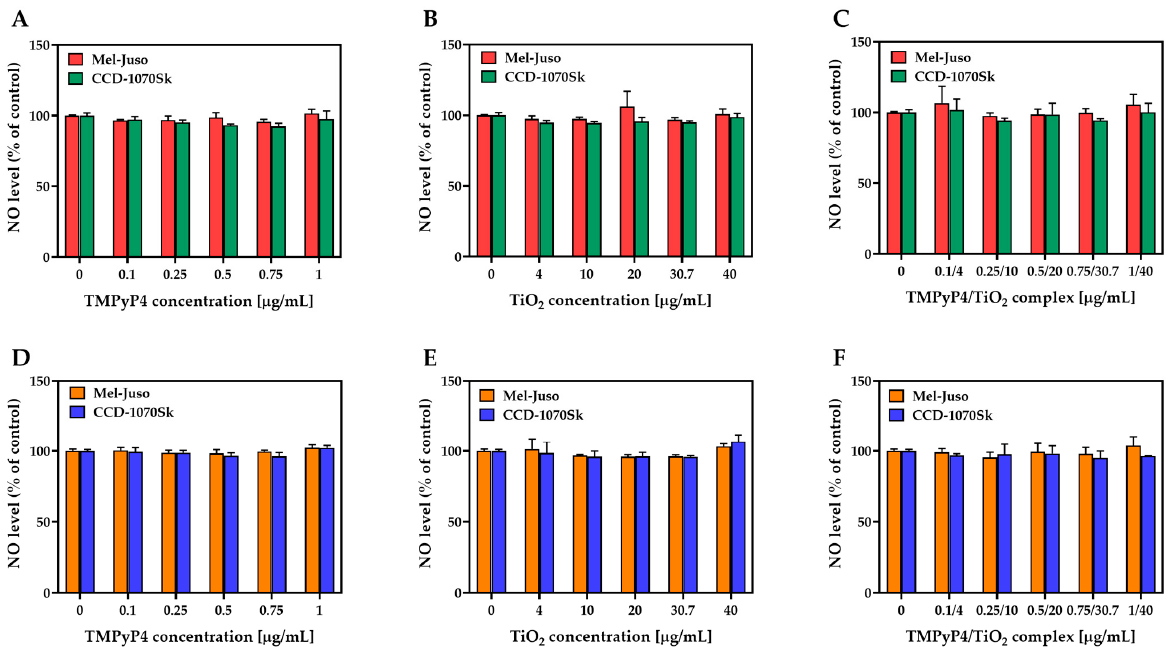
Figure 10. Effect of TMPyP4, TiO 2 NPs, and TMPyP4/TiO 2 complex on nitric oxide (NO) production. The graphs present the relative amount of nitrite released in culture media by treated human Mel- Juso and CCD-1070Sk cells under dark ( A – C ) and light-irradiation conditions ( D – F ). Untreated cells (0 µ g/mL) were used as a control. Error bars reflect the standard deviation.